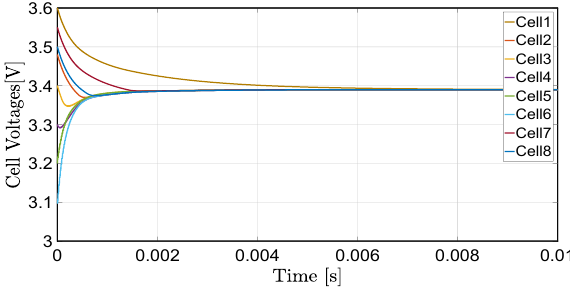
Figure 7. The simulation results of the proposed transformer balancing circuit.